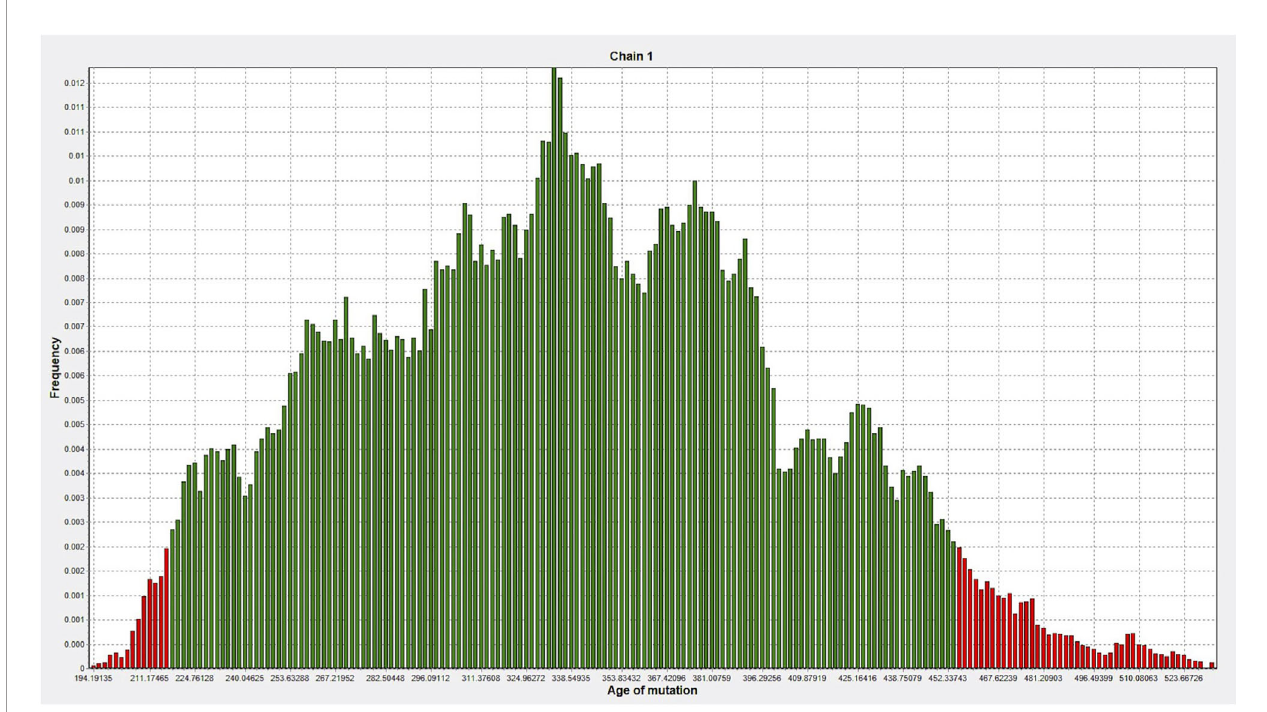
FIGURE 7 | The age of the mutation was simulated 100,000 times by DMLE+2.3. The abscissa represents the age of mutation, in units of generation (about 25 years), and the ordinate represents the frequency (Green, within the 95% con fi dence interval of posterior distribution; Red, outside the 95% con fi dence